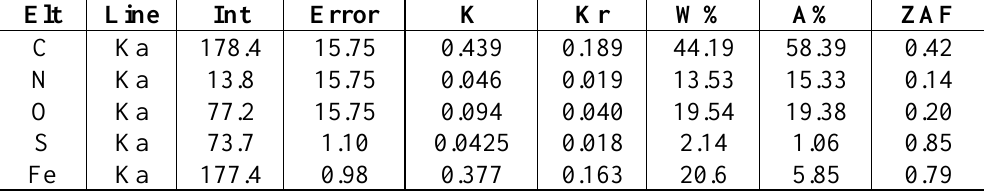
Table 1: The proportions for chemical elements.